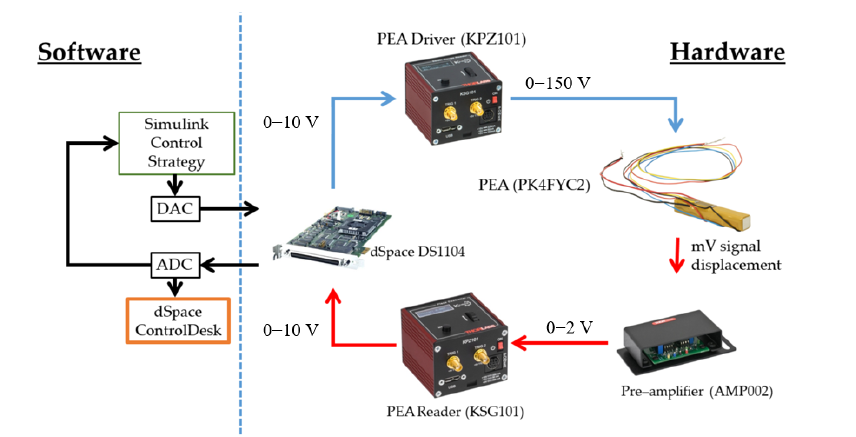
Figure 1. Hardware and software